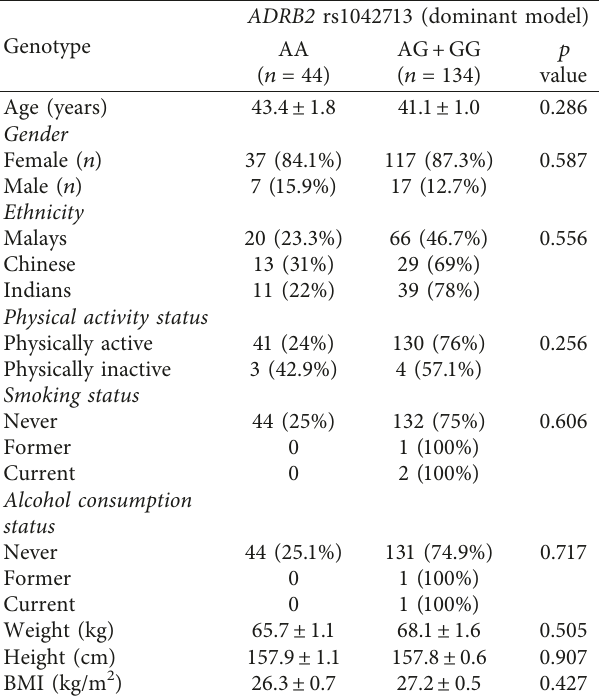
Table 1: General characteristics of the study participants; differ- ences between ADRB2 rs1042713 gene